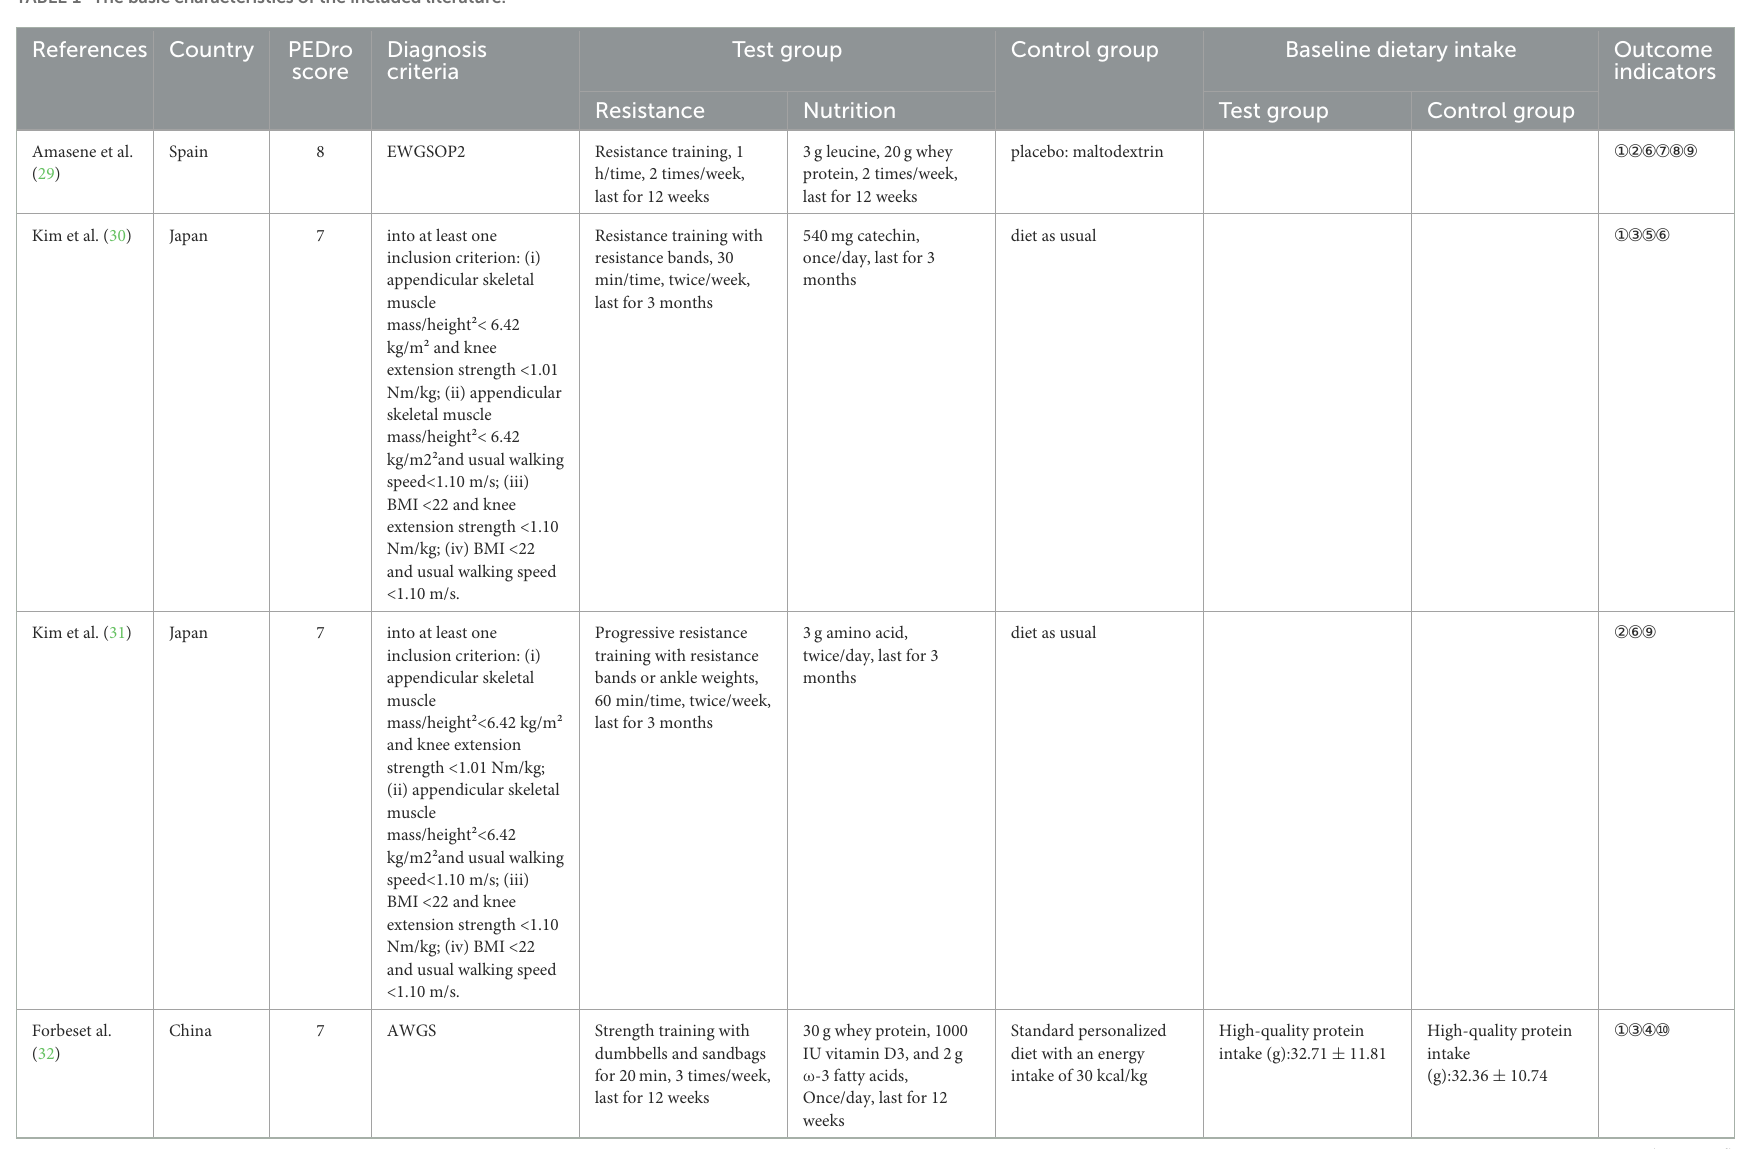
TABLE 1 The basic characteristics of the included